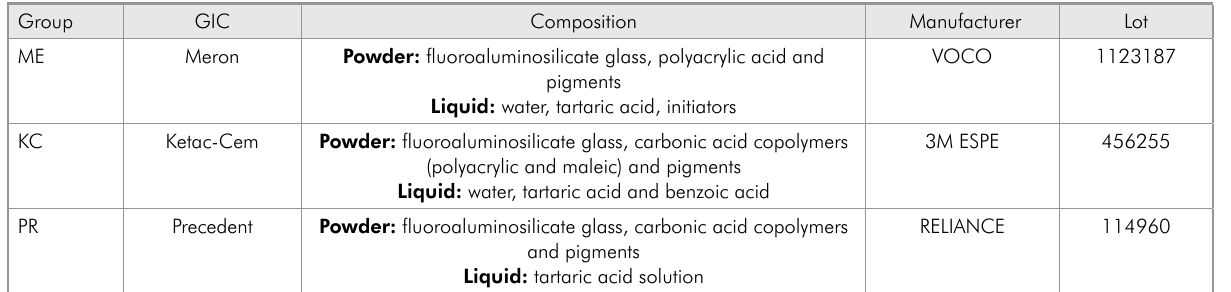
table 1. Composition of the tested glass ionomer cements (GICs). Group GIC